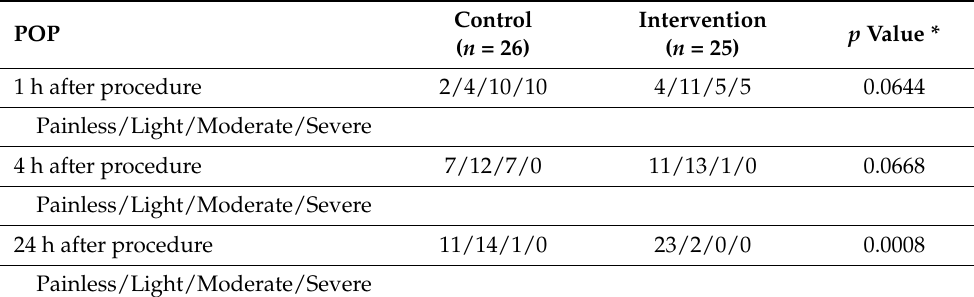
Table 2. POP Values. POP = postoperative Pain; * chi-square